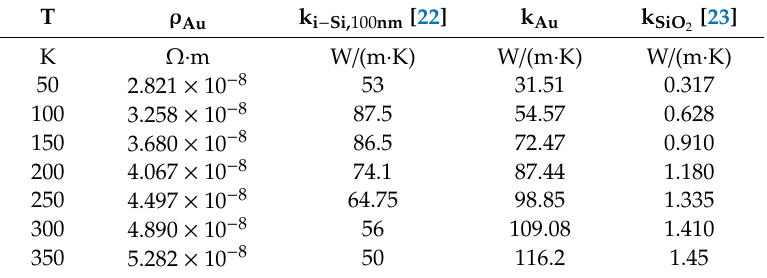
Table 1. Values of the physical properties used in all of the finite element modeling (FEM) simulations. The thermal conductivity of the gold was calculated from the measured resistivity using the Wiedemann–Franz law with L = 2.44 × 10 − 8 W / K. The contact resistivities were also measured at room temperature ρ C = 3.74 × 10 − 9 m 2 (see Appendix A). The data from the references has been extrapolated. T ρ